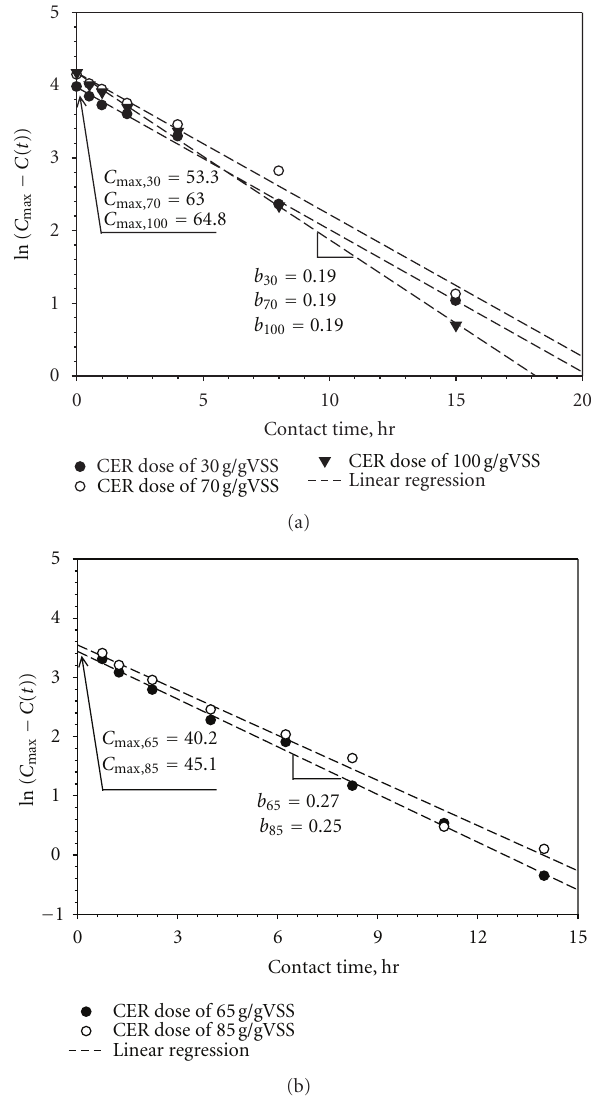
Figure 2: (a) Semilog plots of contact time t and ln[ C max − C ( t )] to determine the parameters, b and C max . (b) Application of (1) and the linear regression of the data referred from Frølund et al. 1995. [18, Figure 1, page